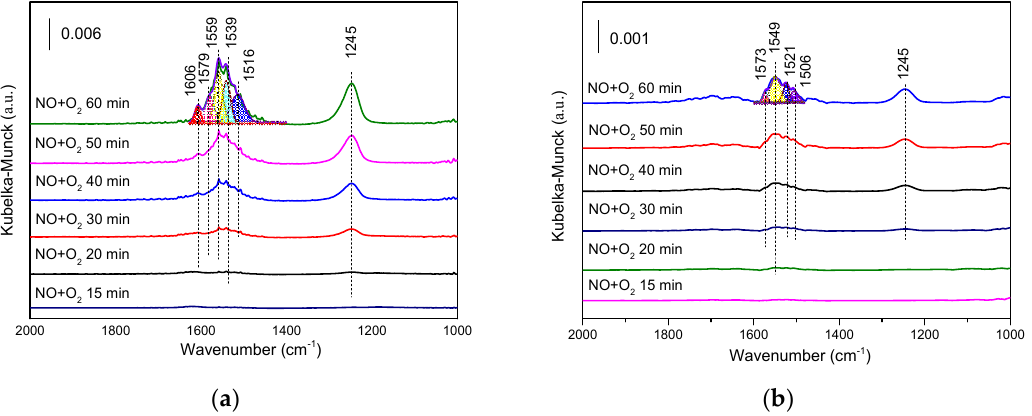
Figure 10. The in situ DRIFT of NO + O 2 co-adsorption over ( a ) the SbCeZr and ( b ) the SbCe catalysts at 200 °C.